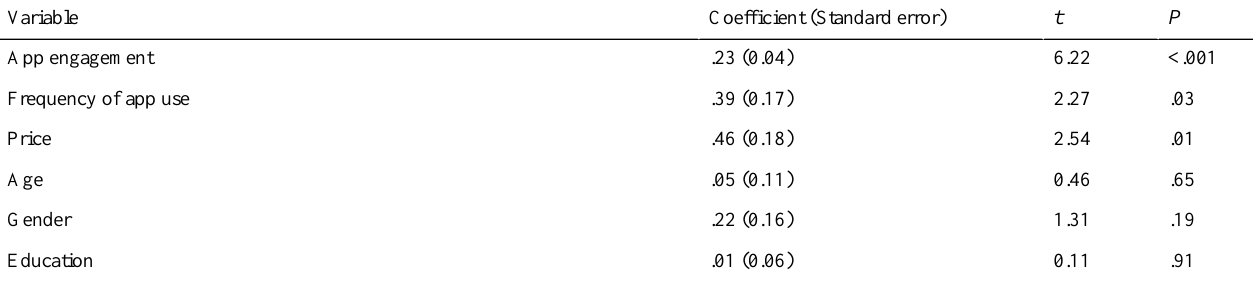
Table 5. Regression analysis and behavior change theory